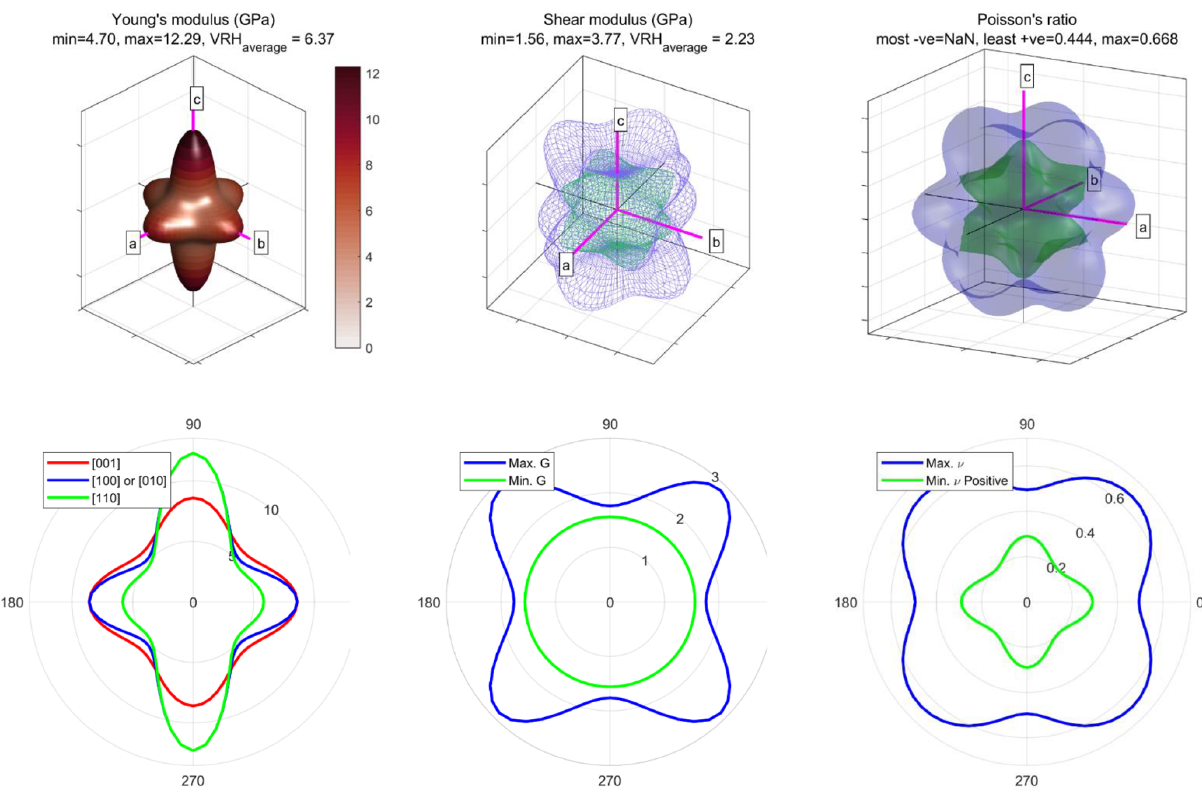
Figure A3. Benchmarks to Tan et al. (2015, their Figs. 2, 3 and 4) for tetragonal ZIF-zni, a zeolite. Plots shown for Young’s modulus, shear modulus and Poisson’s ratio.